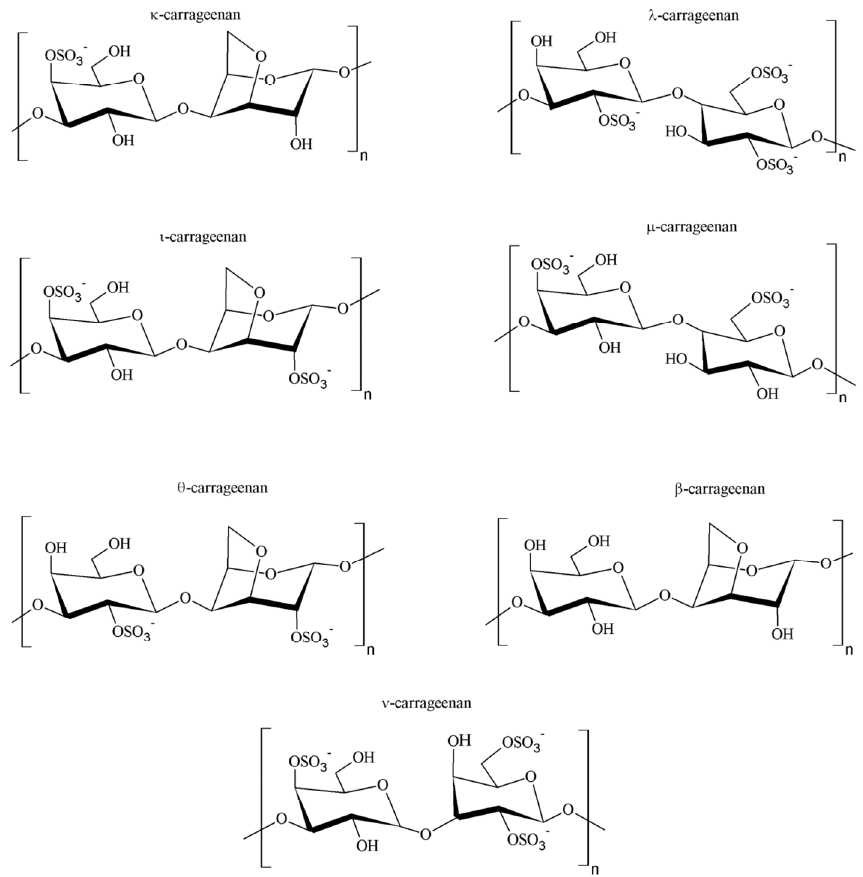
Figure 20. Carrageenan structures. Linear chains of repeating galactose units in D configuration and 3,6-anhydrogalactose copolymer, joined by alternating α -1,3 and β -1,4 glycosidic linkages. Reproduced from [160].